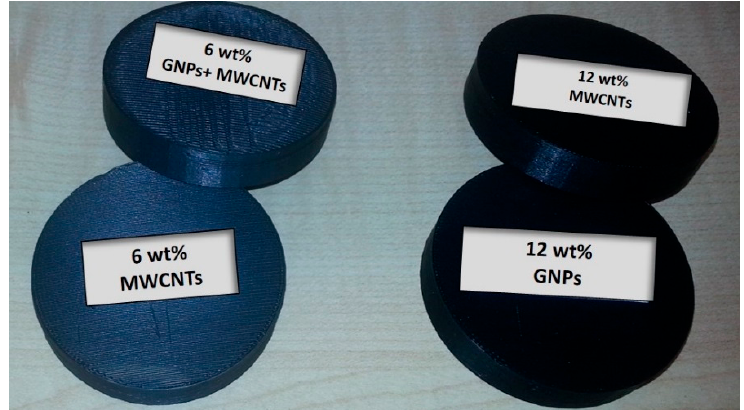
Figure 1. 3D-printed disc specimens.